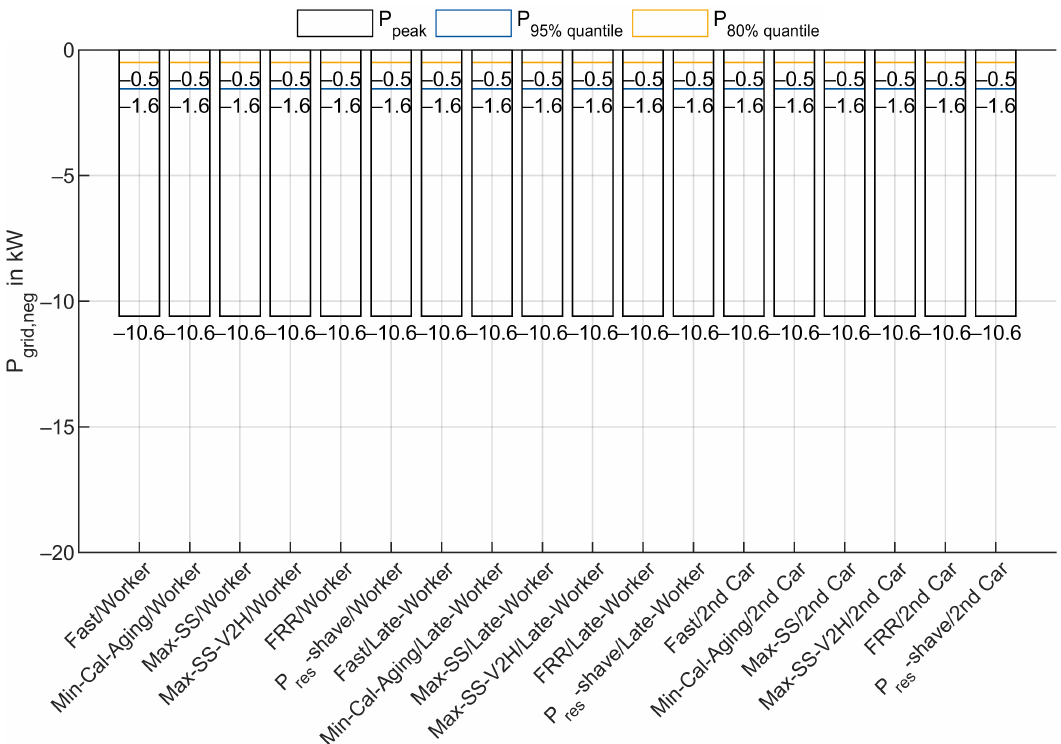
Figure A4. Negative power exchange of the household with the grid for workplace charging scenario W without SoC V 2 XLimit